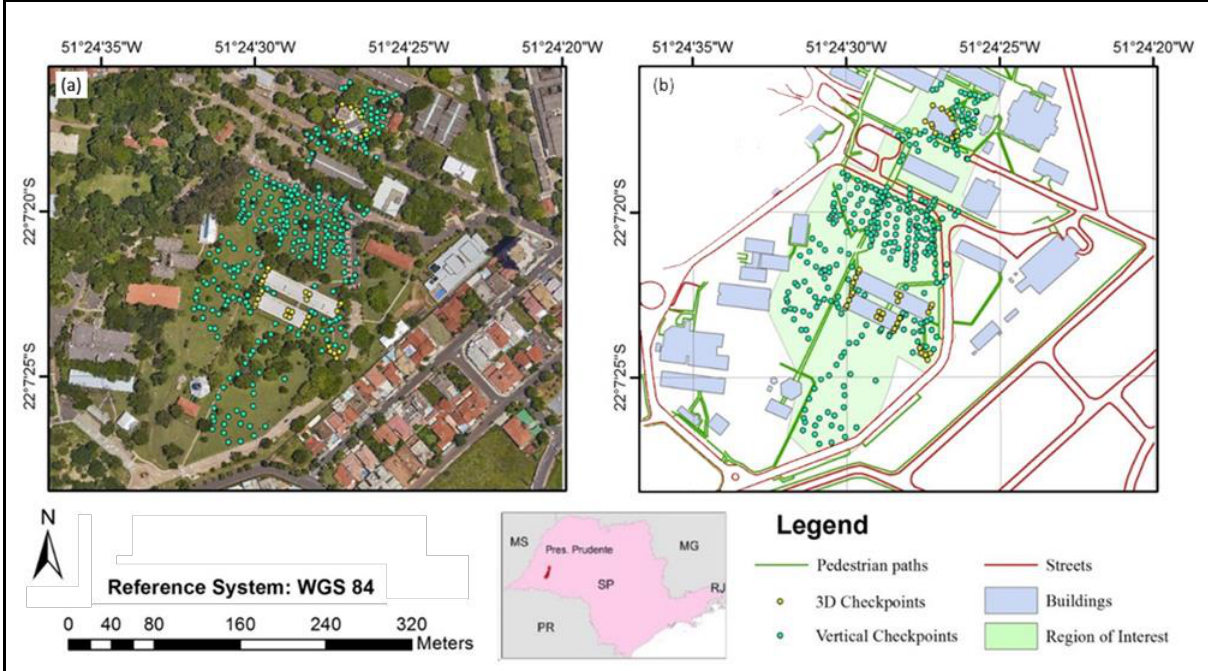
Figure 1 – Study area, the region of interest and checkpoints